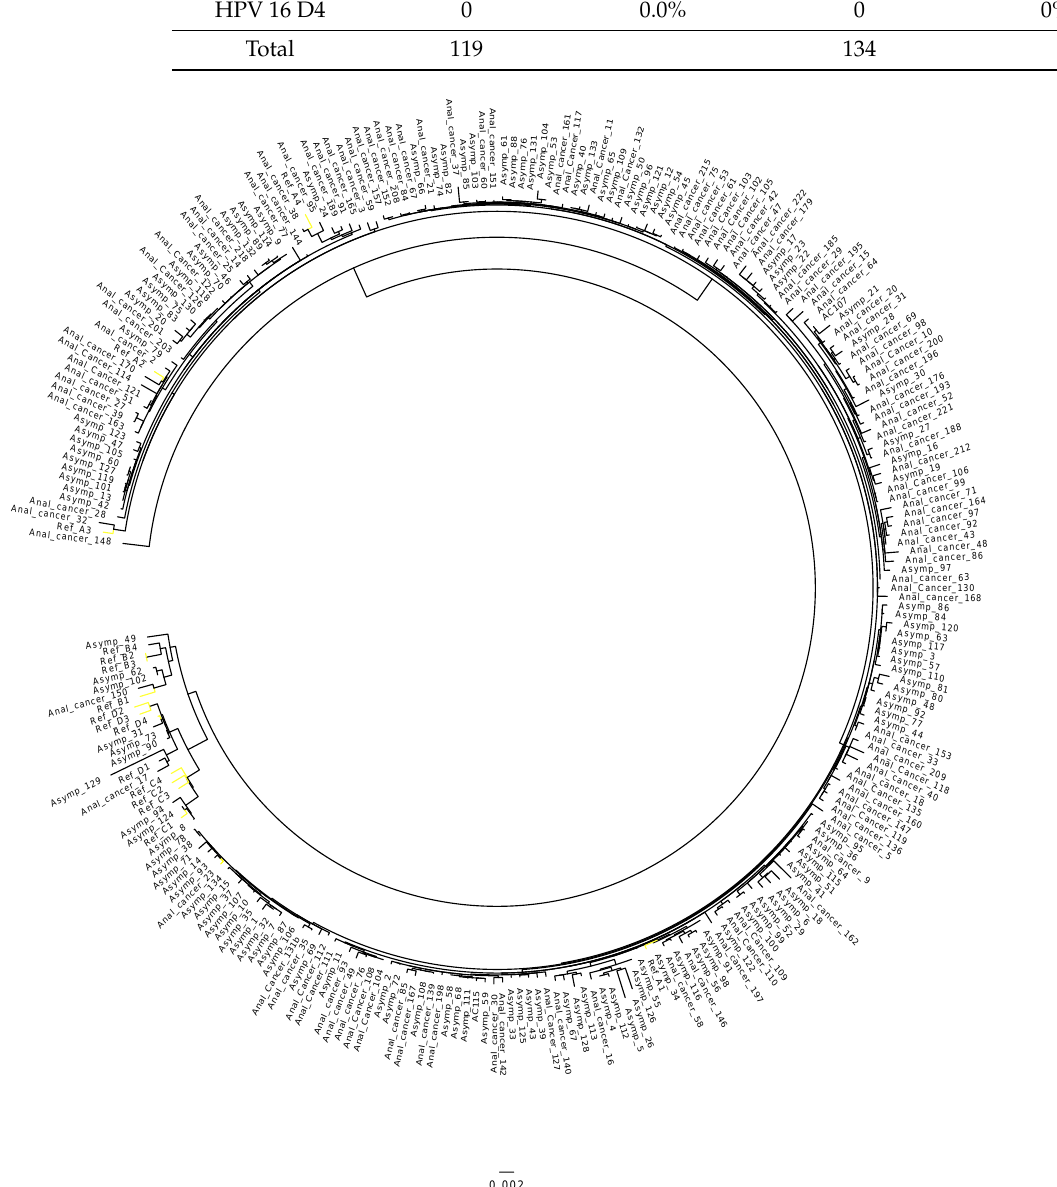
Figure 1. Phylogenetic tree representing the HPV 16 sub-lineages present in the anal sample and control groups.